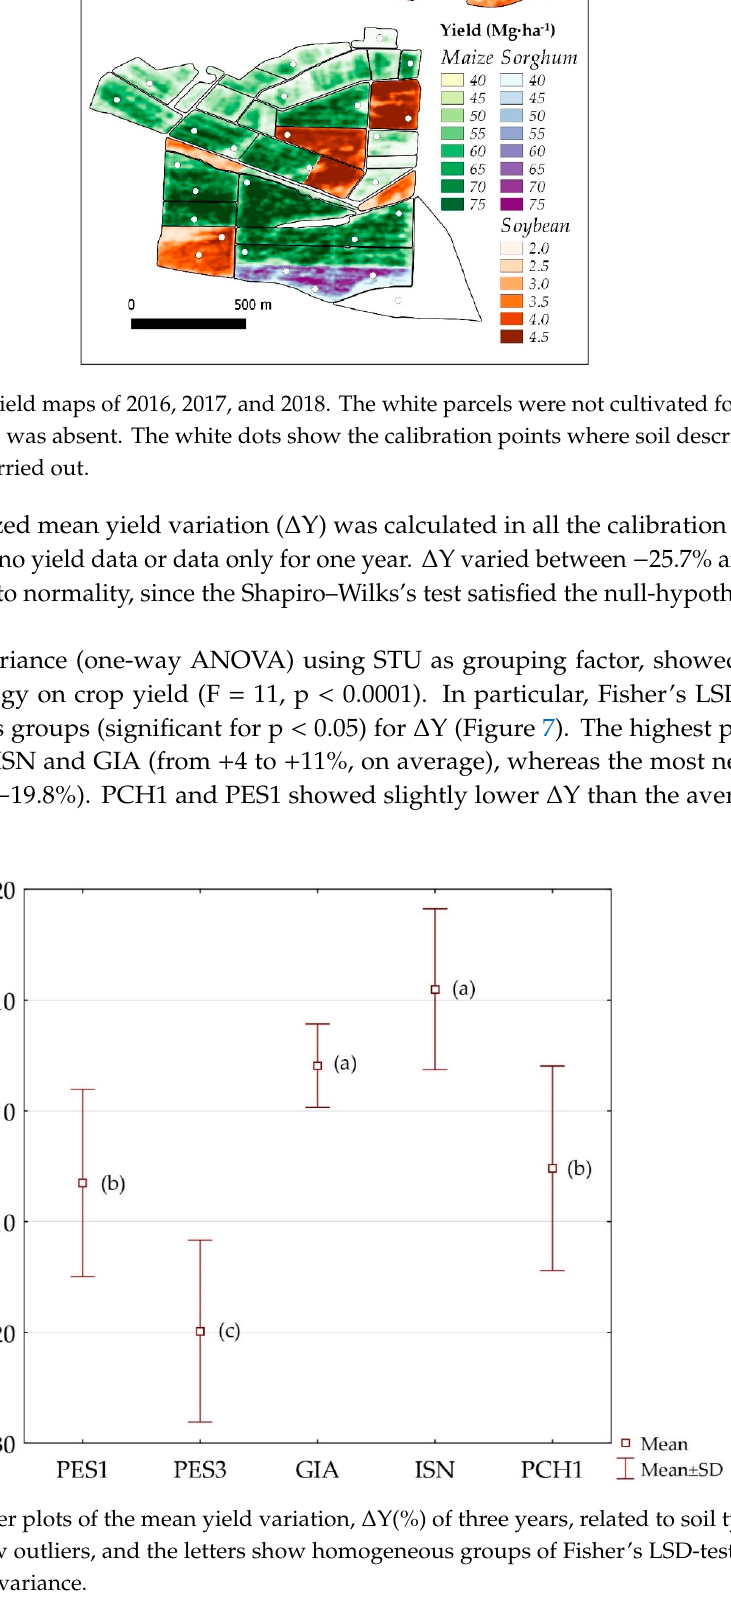
after analysis of after analysis of variance.